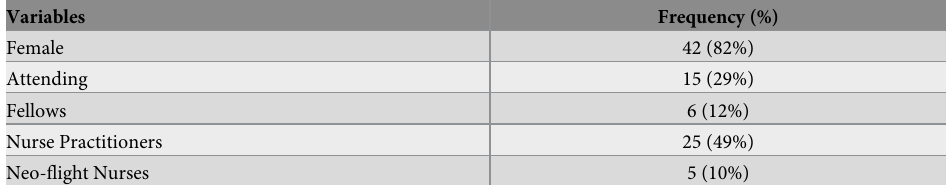
Table 2. Participant population composition.